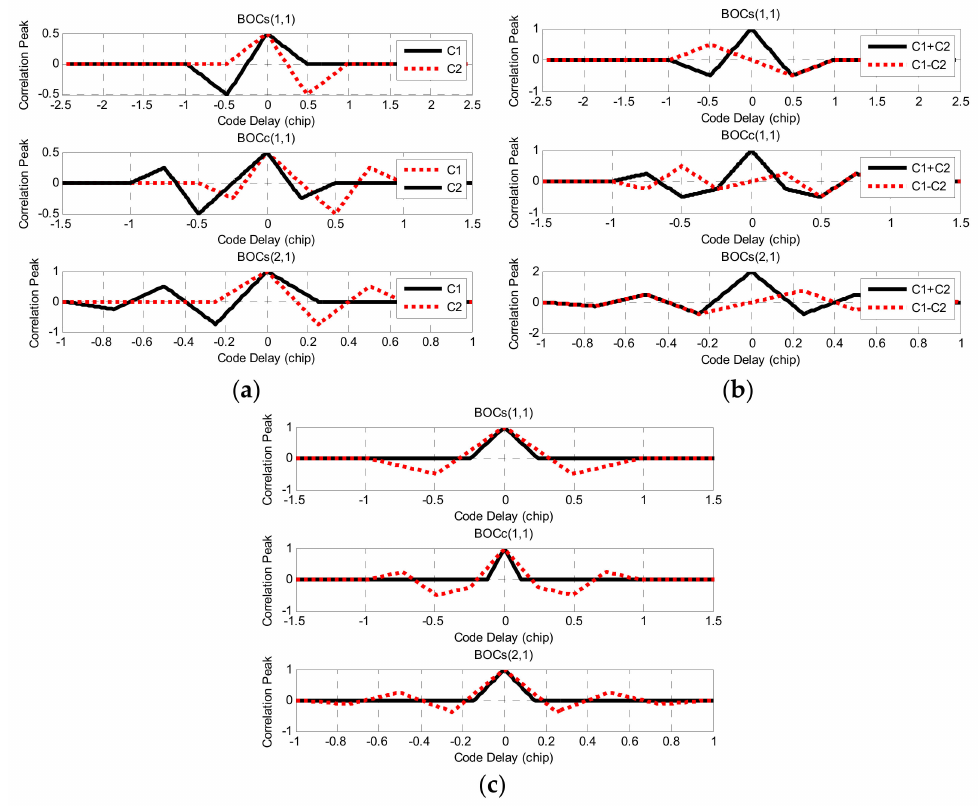
Figure 4. The reconstructed process of the BOCs(1,1), BOCc(1,1) and BOCs(2,1) signals: ( a ) The sub-correlation combination function; ( b ) The simple combination of sub-correlation function; ( c ) The reconstruction of correlation